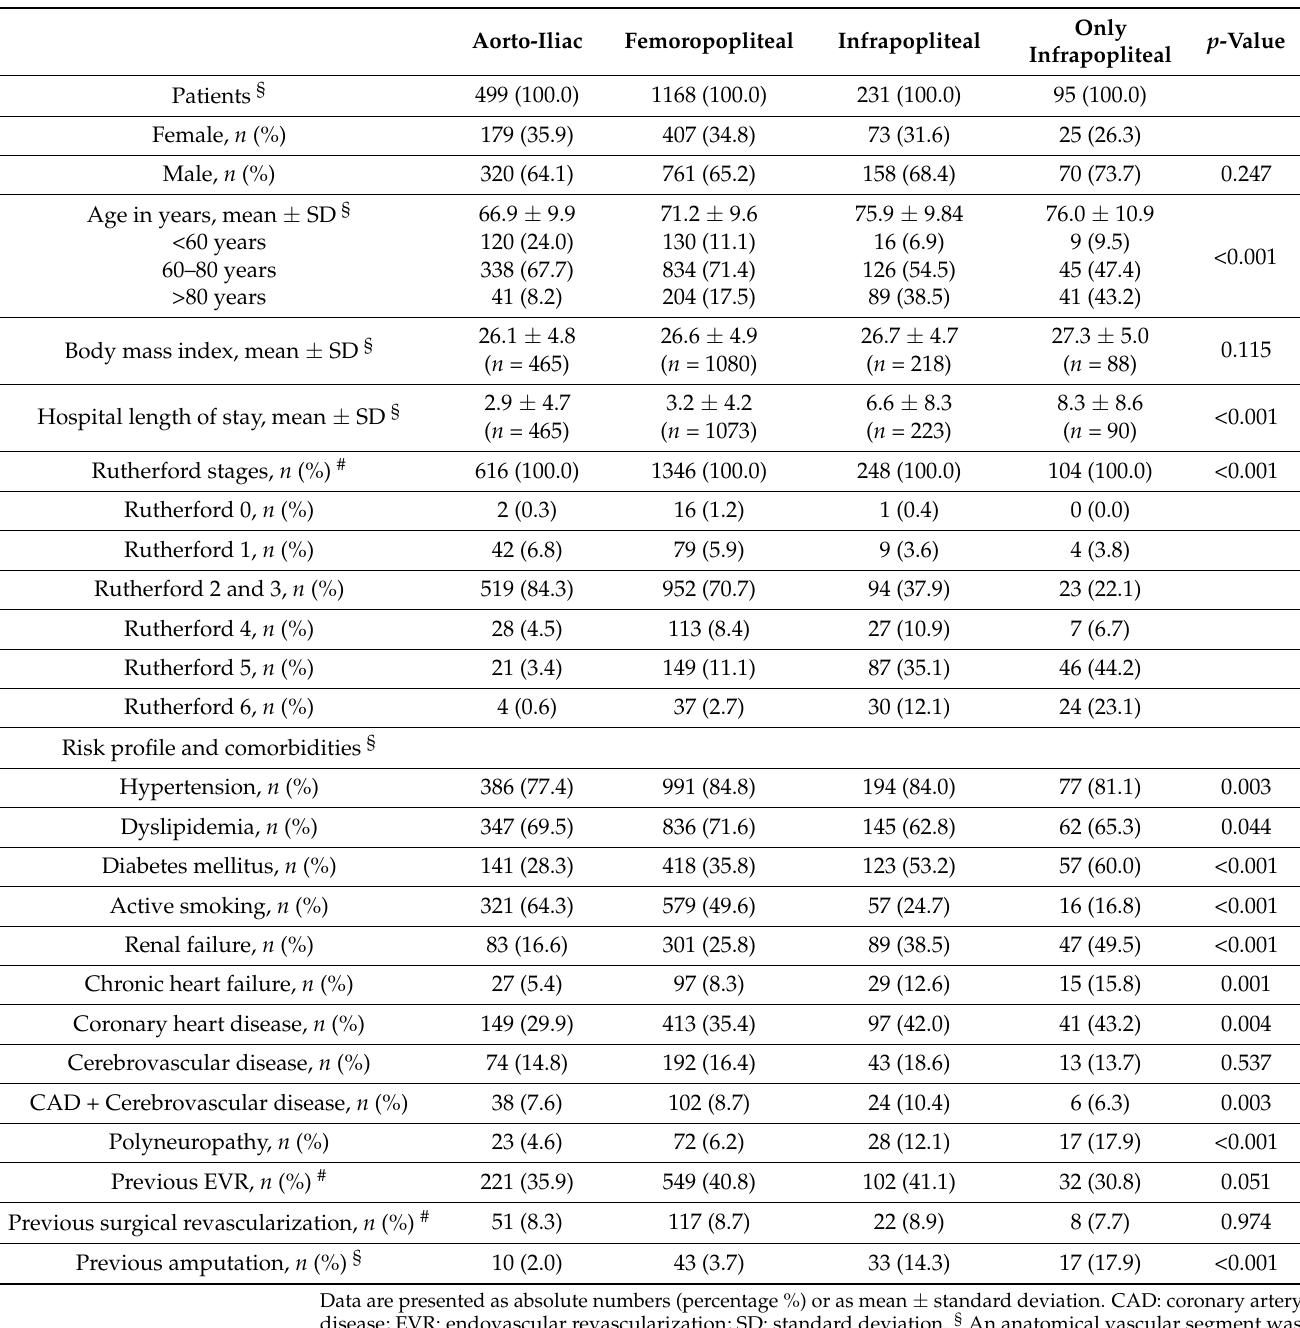
Table 1. Baseline demographic and clinical